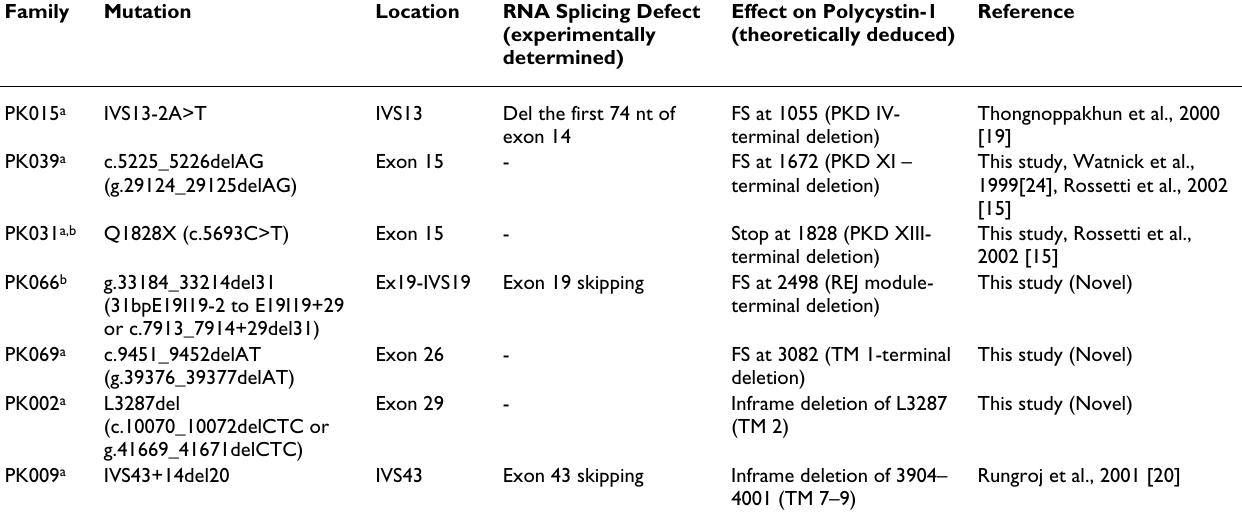
Table 3: PKD1 mutations in Thai families identified by our group